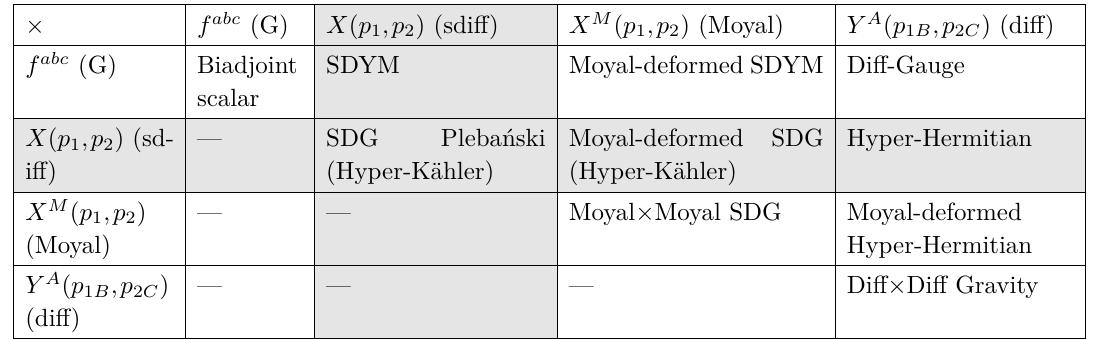
— Diff × Diff Gravity